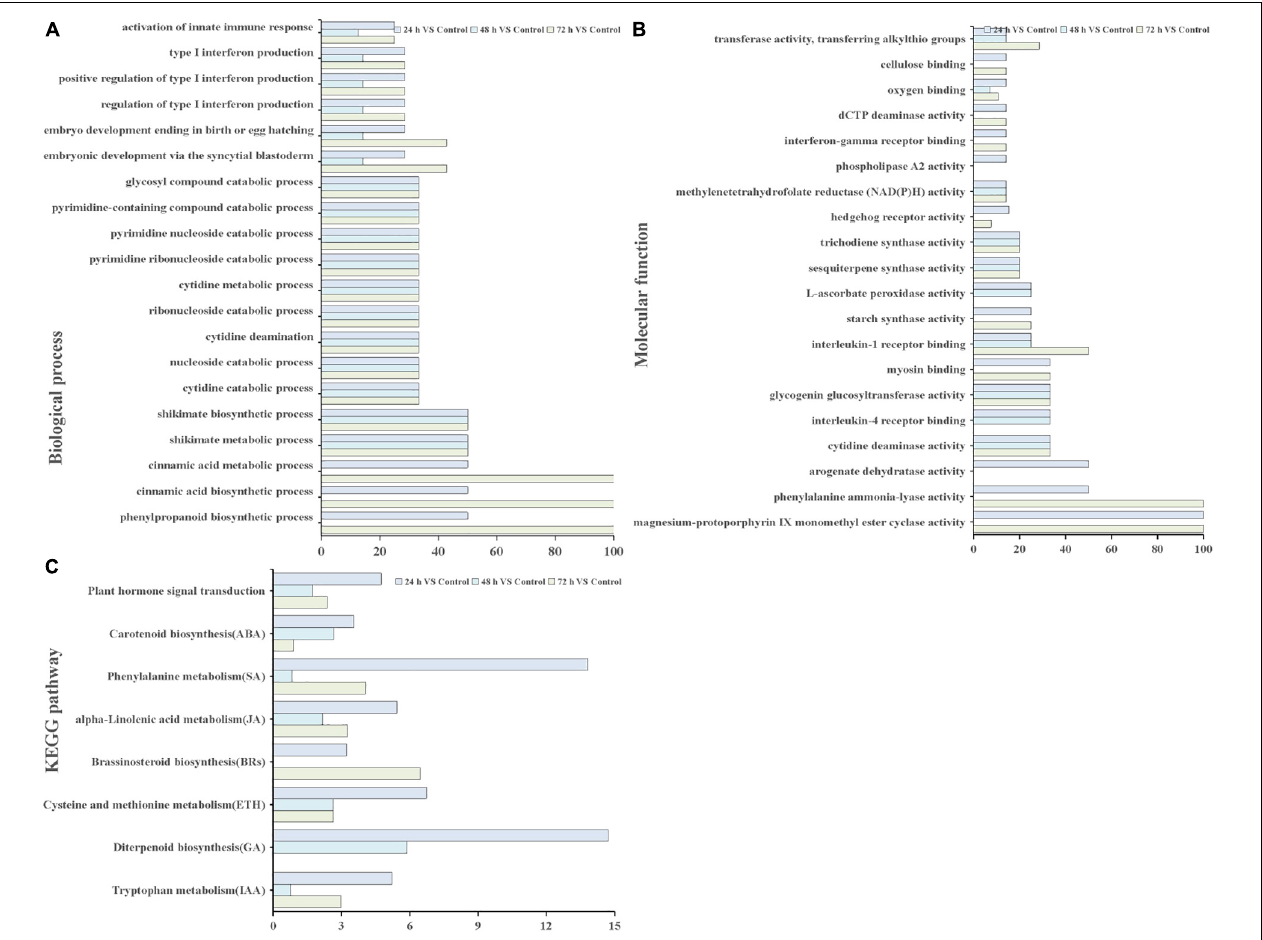
FIGURE 4 | GO terms and KEGG pathways involved in ROS and hormones production analysis. GO analysis of biological process terms (A) , molecular function terms (B,C) KEGG pathways involved in hormones between the cadmium treated transcriptomes compared with the control. The x -axis in (A,B) indicates the percentage of DEG snumbers vs. background gene numbers in each GO term. The x -axis in (C) indicates the percentage of DEGs numbers vs. background gene numbers in each KEGG